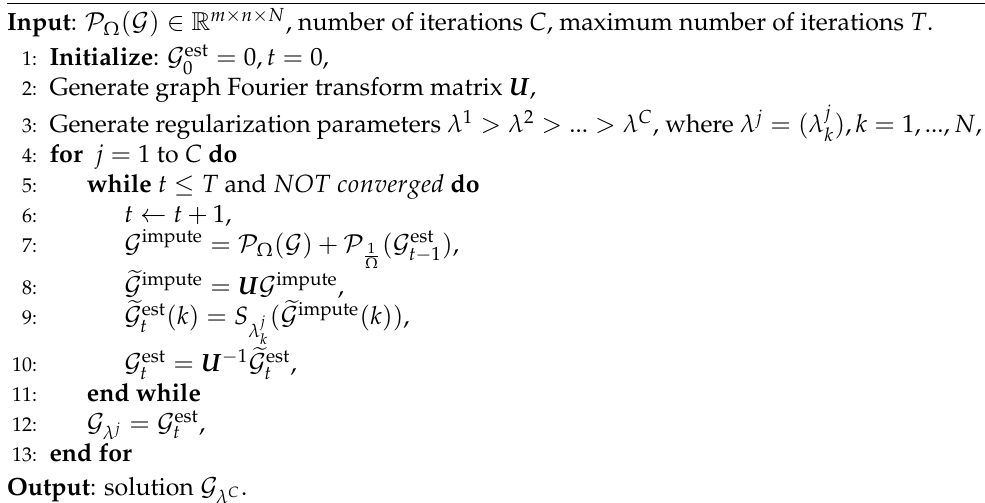
Algorithm 1 Iterative convolutional